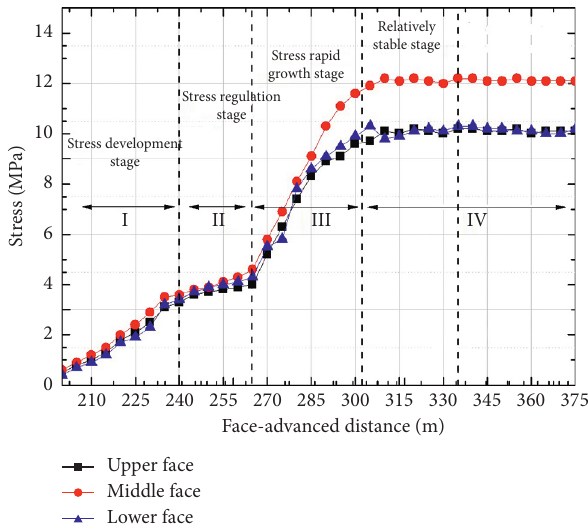
Figure 17: Trends of roof subsidence with the advance of the face. Figure 16: Trends of the stress of CCGPB with the advance of the